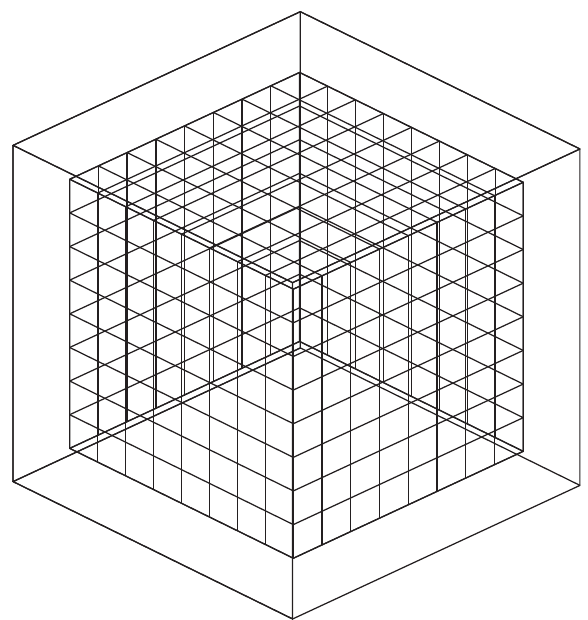
Figure 7: Physical probability model of damage degree for asphalt mixtures subjected to freezing and